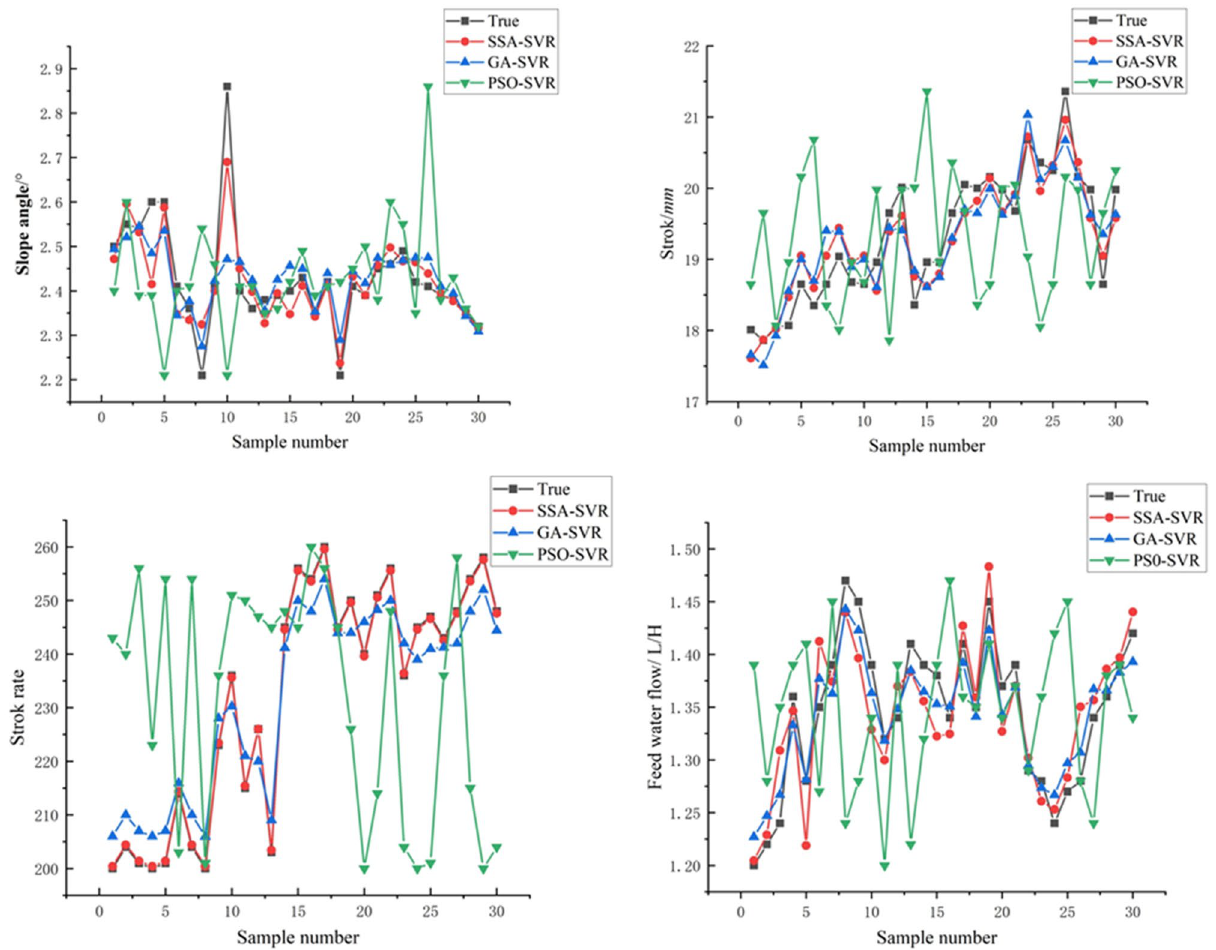
Figure 7. Simulation results of the models on control parameters of shaking